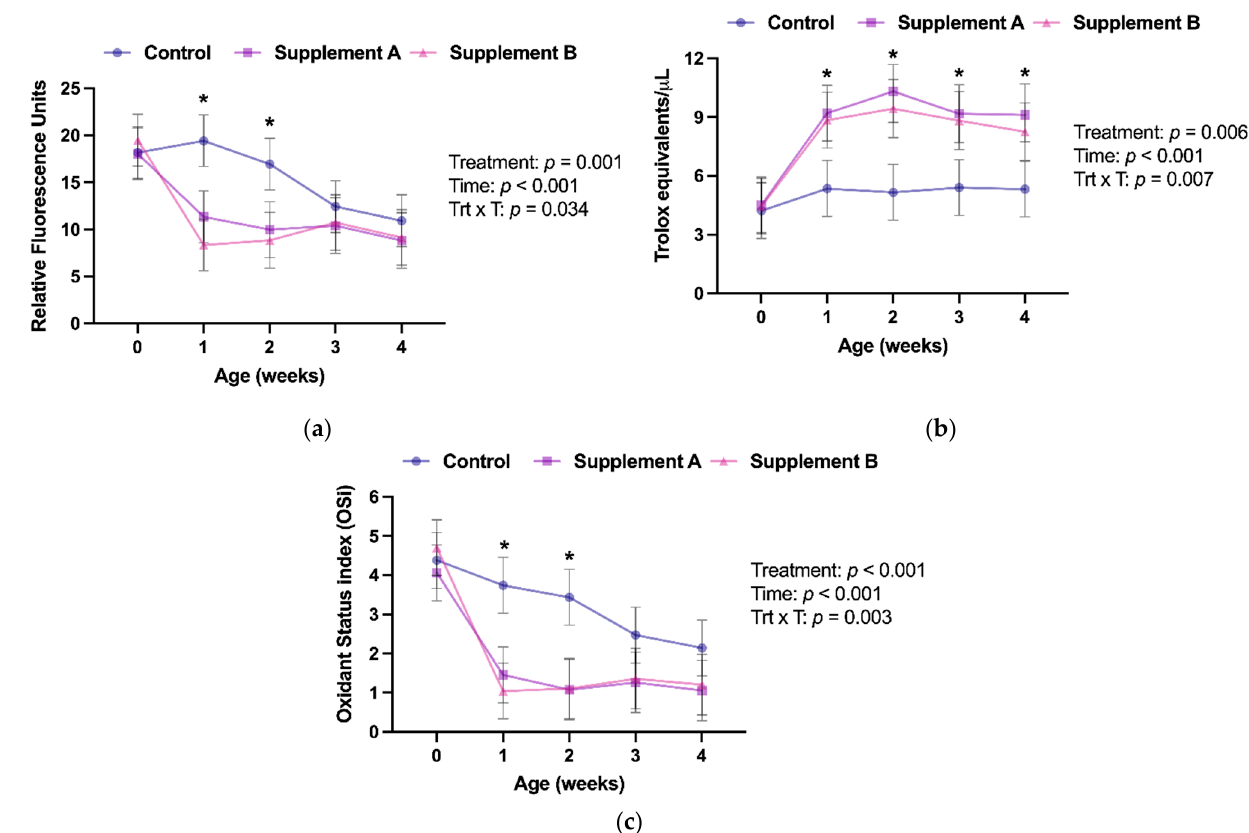
Figure 1. Changes in ( a ) Reactive Oxygen and Nitrogen Species, ( b ) Antioxidant Potential, and ( c ) Oxidant Status index (arbitrary units) throughout the first 4 weeks of age. Results were analyzed using mixed models with repeated measures, including the main effects of treatment (control, supplement A, or supplement B), time (weeks of age), and the treatment x time interaction (Trt x T). Week 0 samples were collected prior to colostrum ingestion or administration of treatments. Results are presented as least squares means and 95% confidence intervals. * denotes differences ( p < 0.05) between the control and the supplement groups at a given age point as reported by Tukey’s honest significance